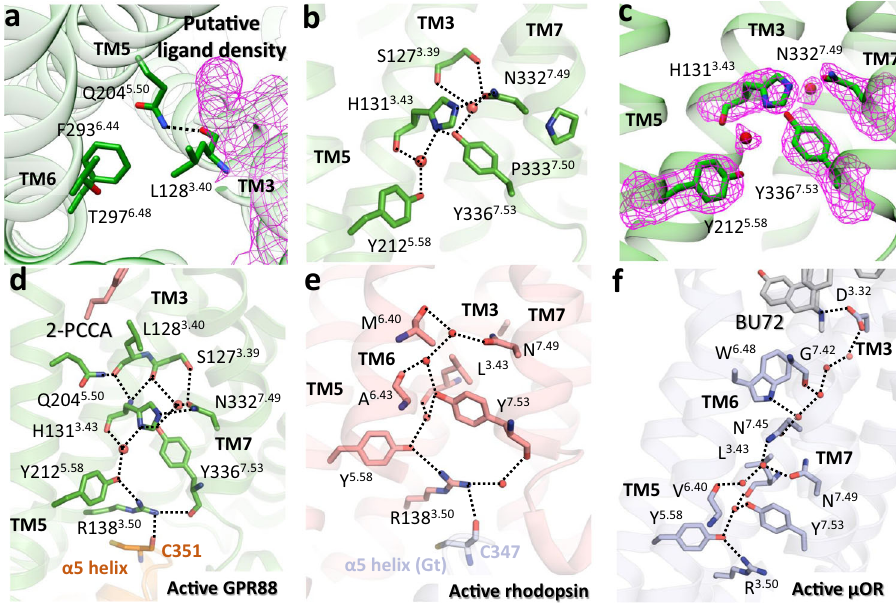
Fig. 3 The active state GPR88 and the water-mediated hydrogen-bonding network. a The active conformation of T 6.48 and the Q 5.50 -L 3.40 -F 6.44 triad. b The N 7.49 P 7.50 xxY 7.53 motif and two water molecules in the receptor core. c The electron densities of the two water molecules and surrounding residues. d – f Water-mediated hydrogen-bonding networks in the active GPR88 ( d ), rhodopsin ( e , PDB: 2 × 72), and the μ OR ( f , PDB: 5C1M). Polar interactions are highlighted as dash